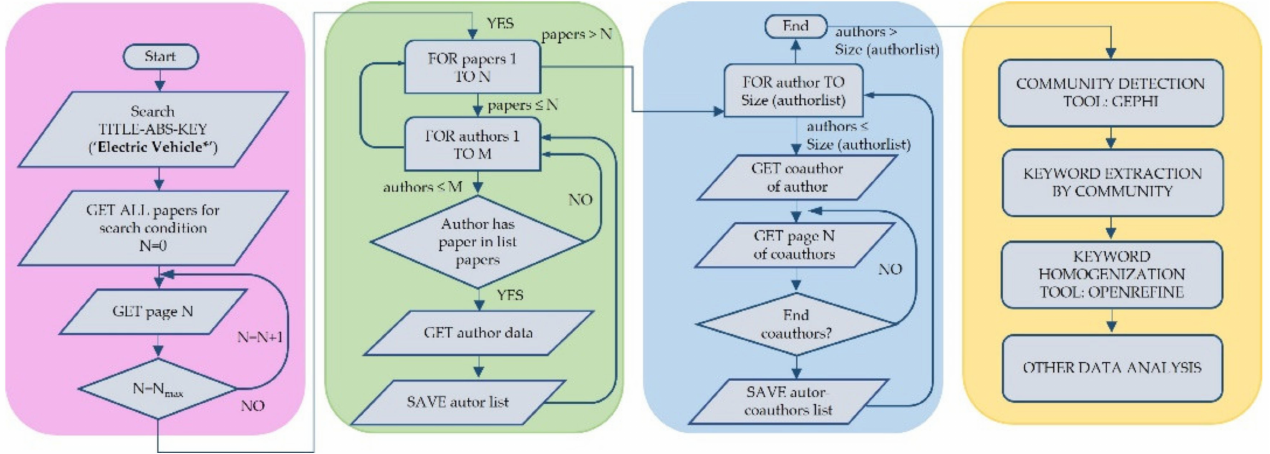
Figure 1. Flowchart for ResNetBOT automated